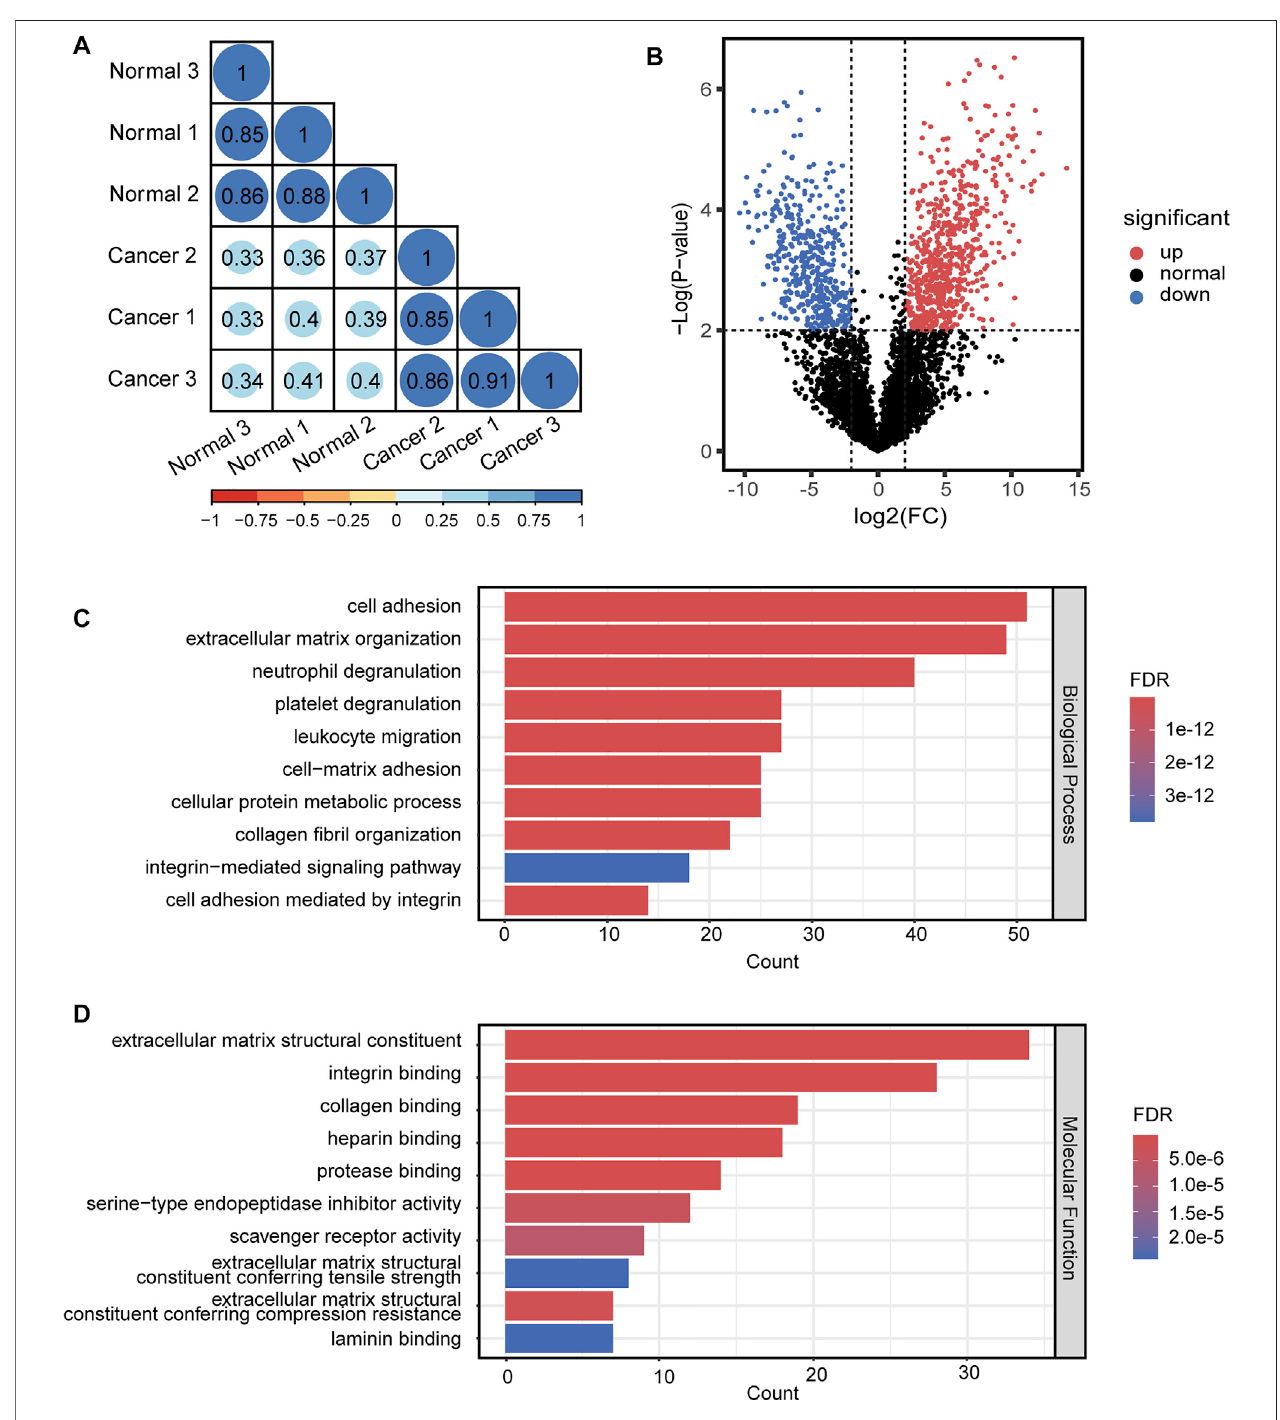
FIGURE 8 | Quantitative differential analysis and GO analysis of N-glycopeptides from lung cancer and normal tissue. (A) quanti fi cation correlation of N-glycopeptides. (B) volcanoplotofN-glycopeptides. (C) biologicalprocessofGOanalysisofthedysregulatedN-glycoproteins. (D) molecularfunctionofGOanalysisof the dysregulated